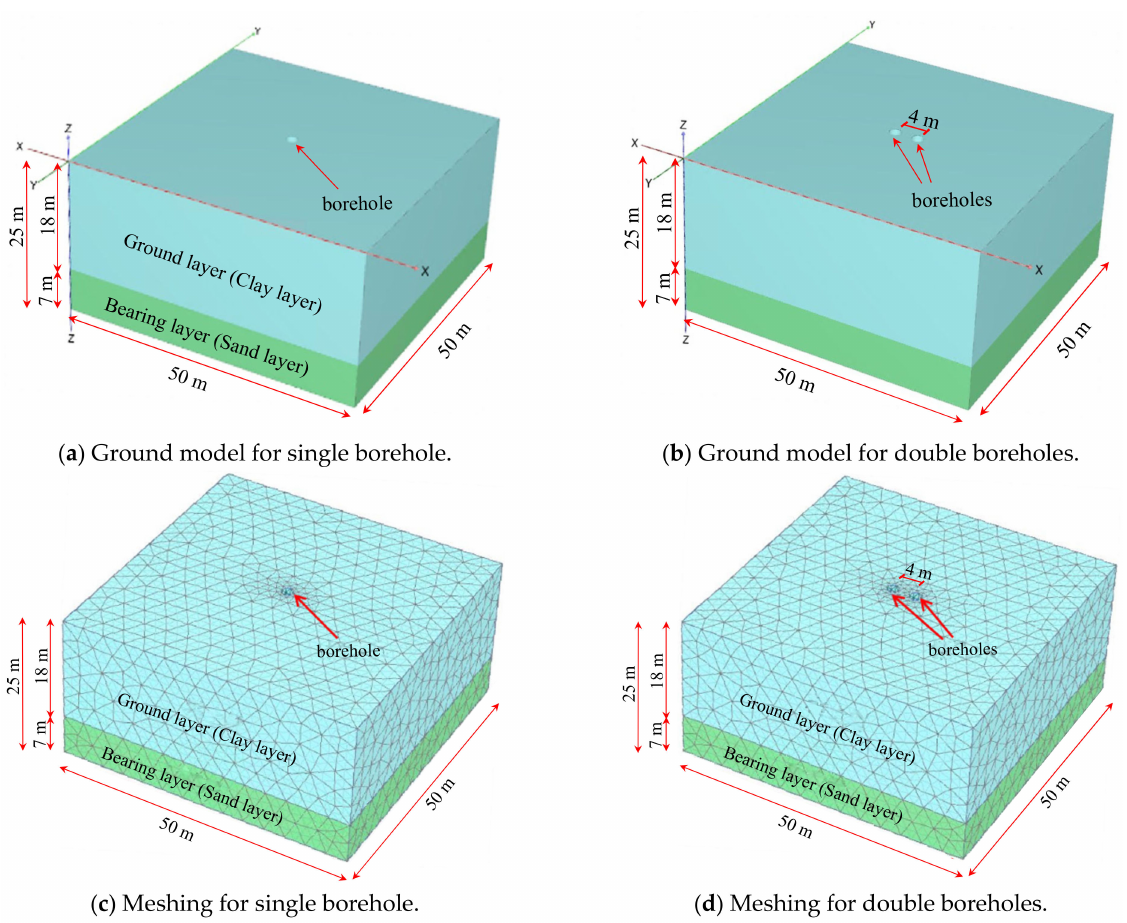
Figure 1. Analytical ground models for single and double